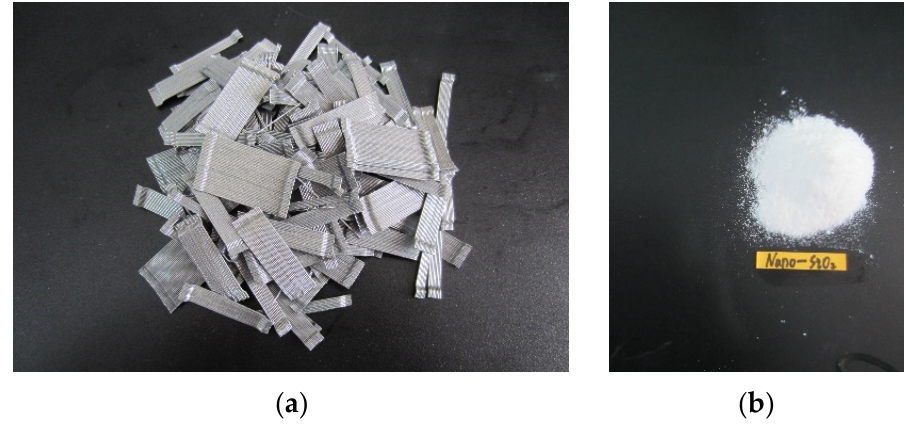
Table 1. Detailed parameters of the test specimens. Figure 1. Materials: ( a ) steel fiber; ( b ) Nano–SiO 2. Figure 1. Materials: ( a ) steel fiber; ( b ) Nano–SiO 2.